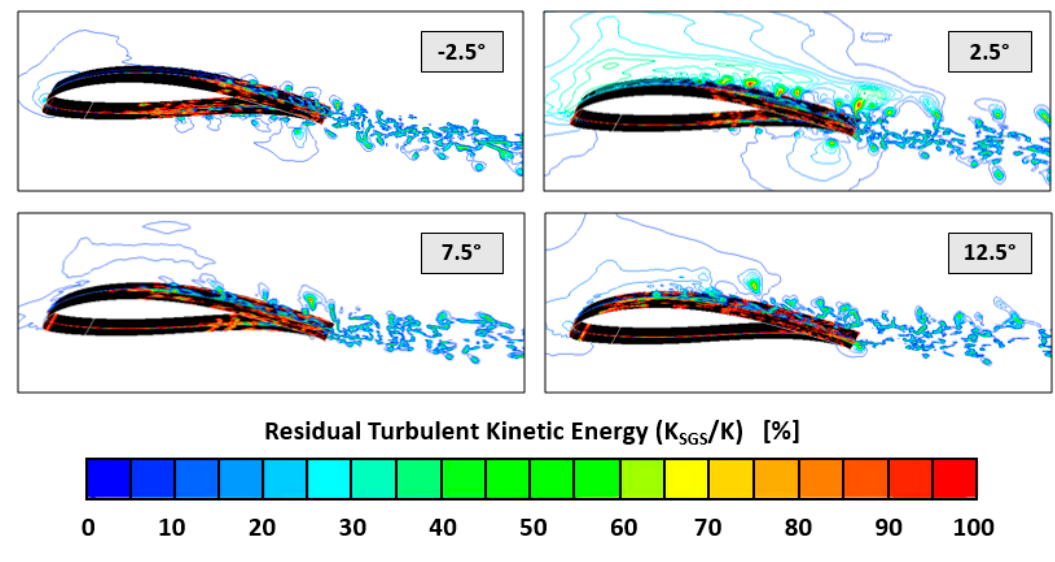
Figure 10. Residual turbulent kinetic energy for di ff erent angles of attack. Table 1. Volume-averaged values of residual turbulent kinetic energy (TKE) in the domain at di ff erent angles of